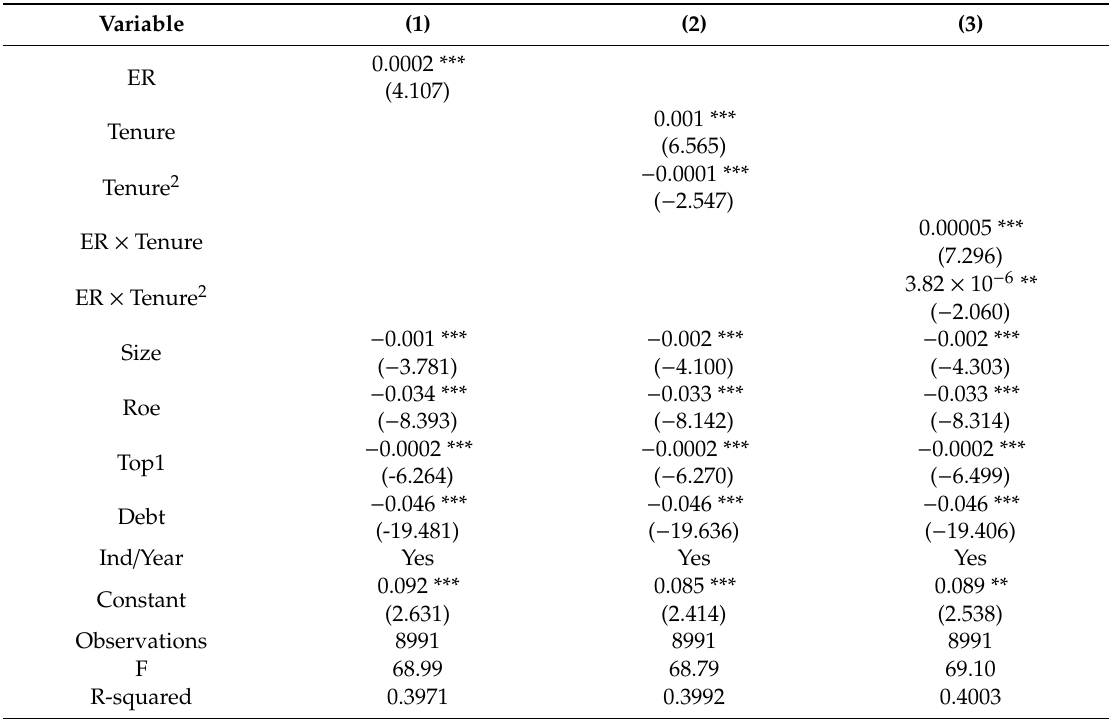
Table 5. Regression coe ffi